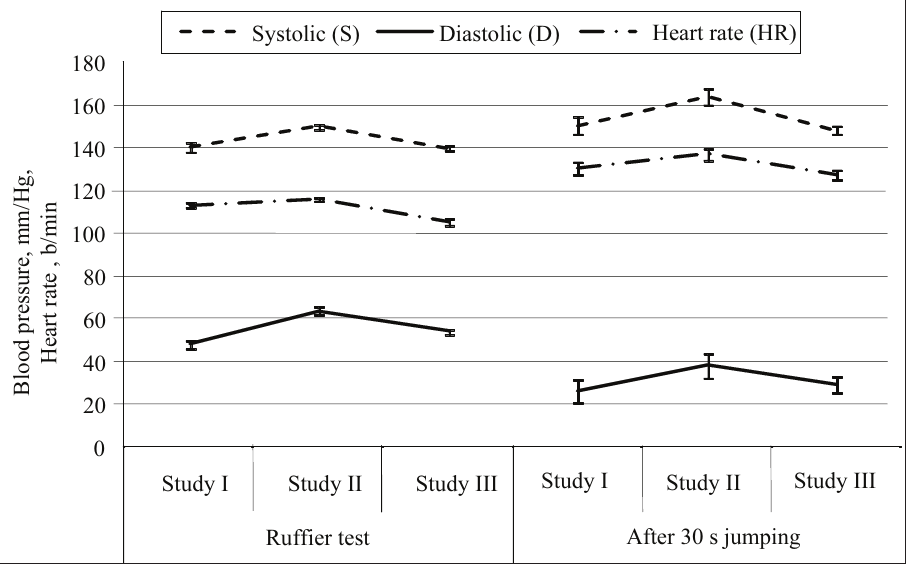
Figure 1. ABP and HR values at the end of modified Ruffier functional test and after 30 s vertical jumps